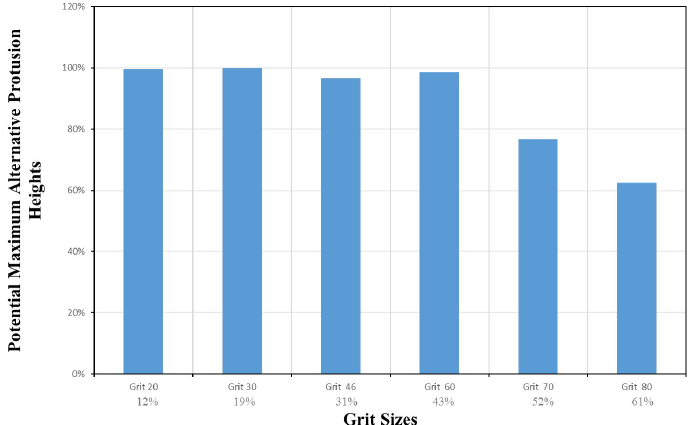
Figure 35. Potential maximum of alternative protrusion height dependent on the grit sizes for a fixed dressing depth of 0.1